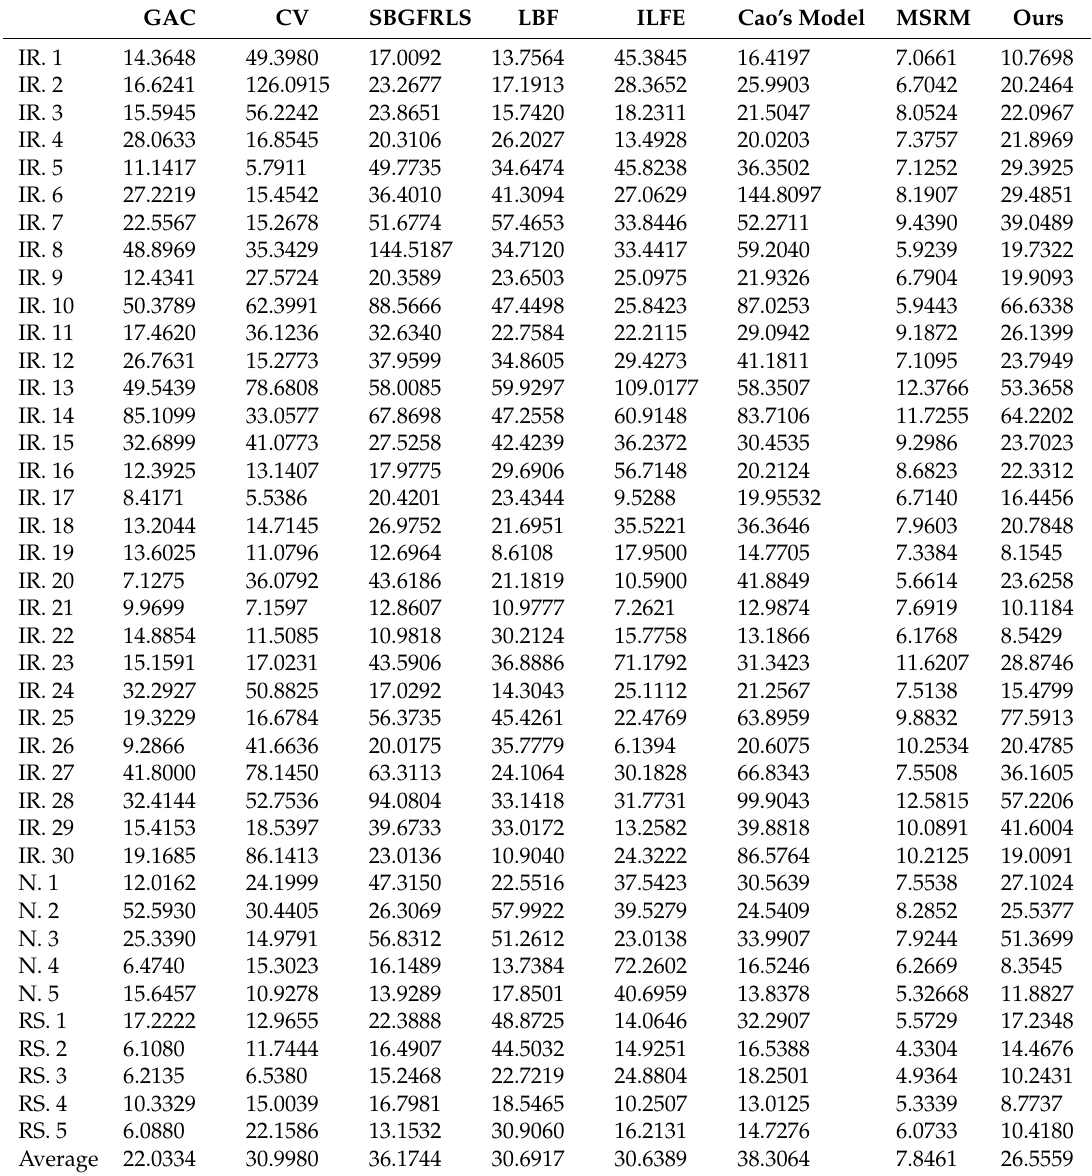
Table 5. Comparison of running time (in